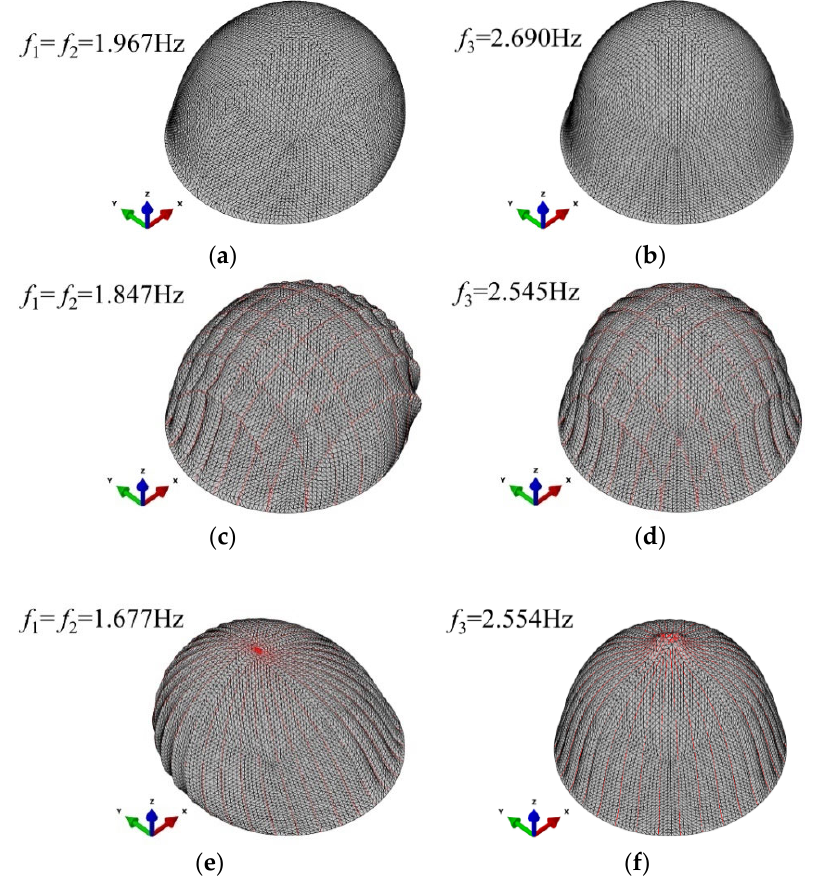
Figure 8. Contours of membrane stress with different mesh levels.